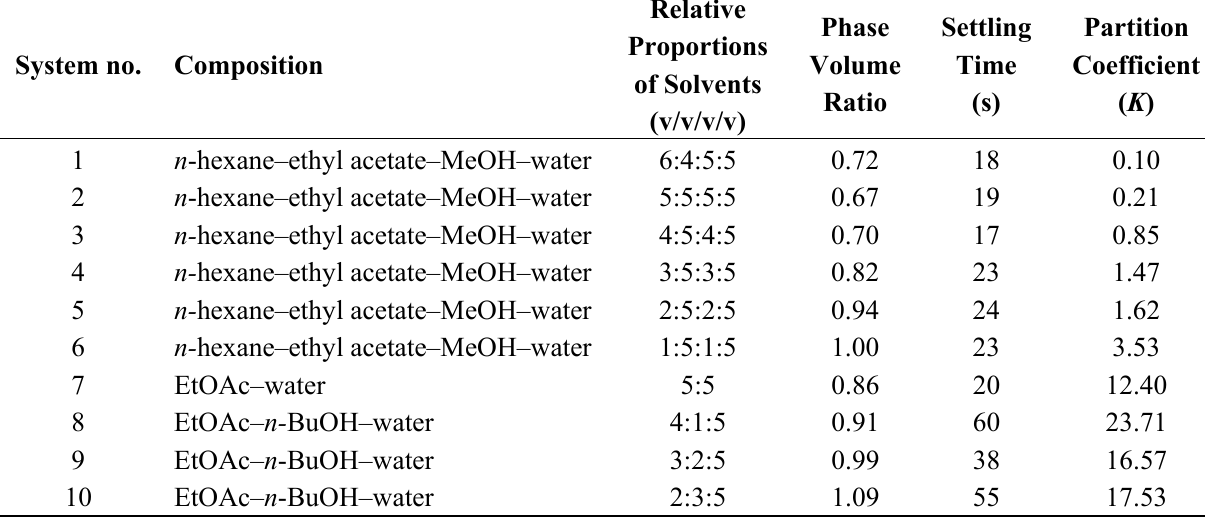
Relative Phase Proportions Volume of Solvents (v/v/v/v)